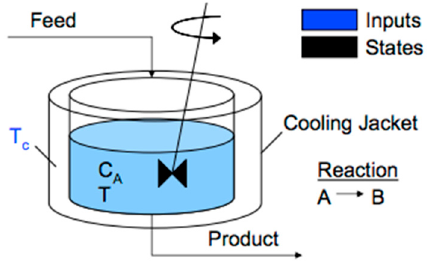
Figure 6. Graphical representation of the Continuous Stirred Tank Reactor (CSTR) system.